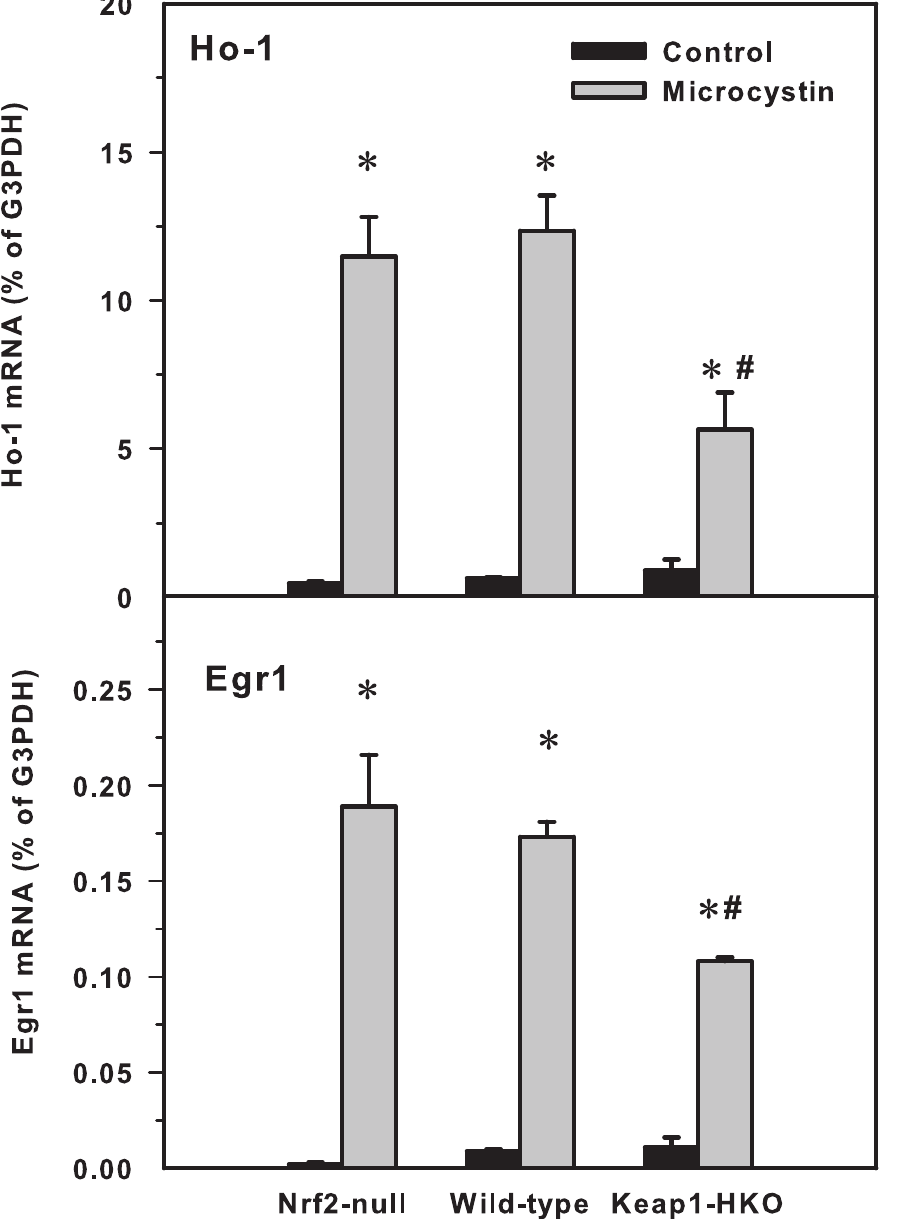
Figure 6. The mRNA levels of glutathione conjugation enzymes Gst a 1, Gst a 4, Gts m and Gpx2 in Nrf2-null, wild-type and Keap1-HKO mice administered saline (10 ml/kg, i.p.) or microcystin (50 m g/kg, i.p.). Livers were removed 8 h after microcystin and mRNA quantified by RT-PCR. Values are expressed as mean 6 S.E.M. (n=8). *Significantly different from the basal level of the same genotype (p # 0.05); # Significantly different from Nrf2-null mice treated with microcystin (p # 0.05).